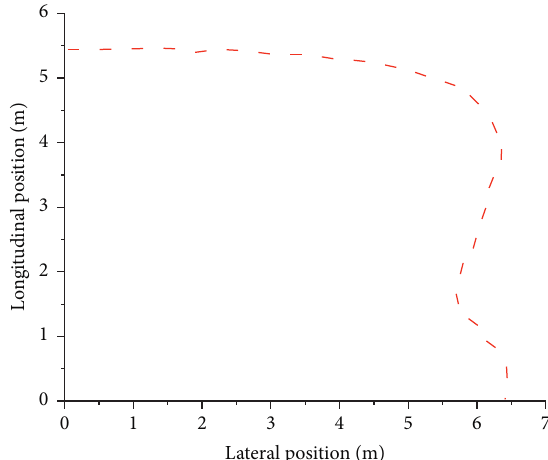
Figure 3: Curve of the coal gangue boundary.